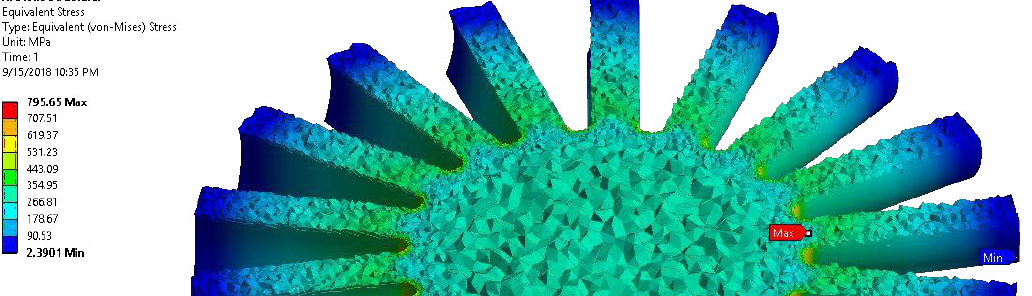
Figure 43. Rotor stress section view (von Mises).